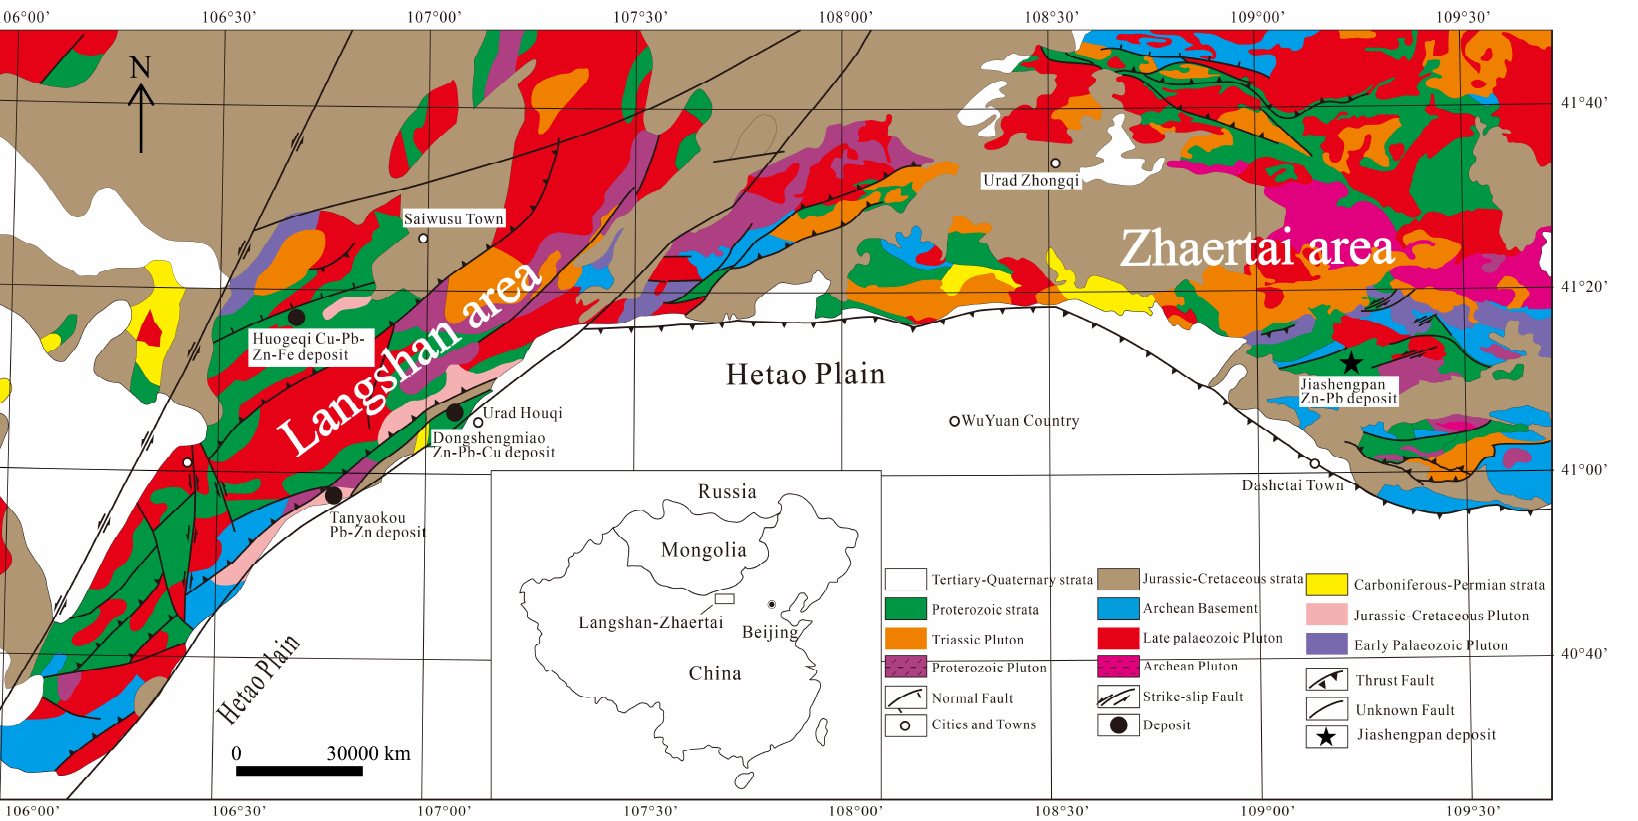
Figure 1. Regional geology of Langshan-Zhaertai district (modified from 1:500,000 regional geological map provided by the Bureau Geological Mineral Exploration and Development in Inner Mongolia).